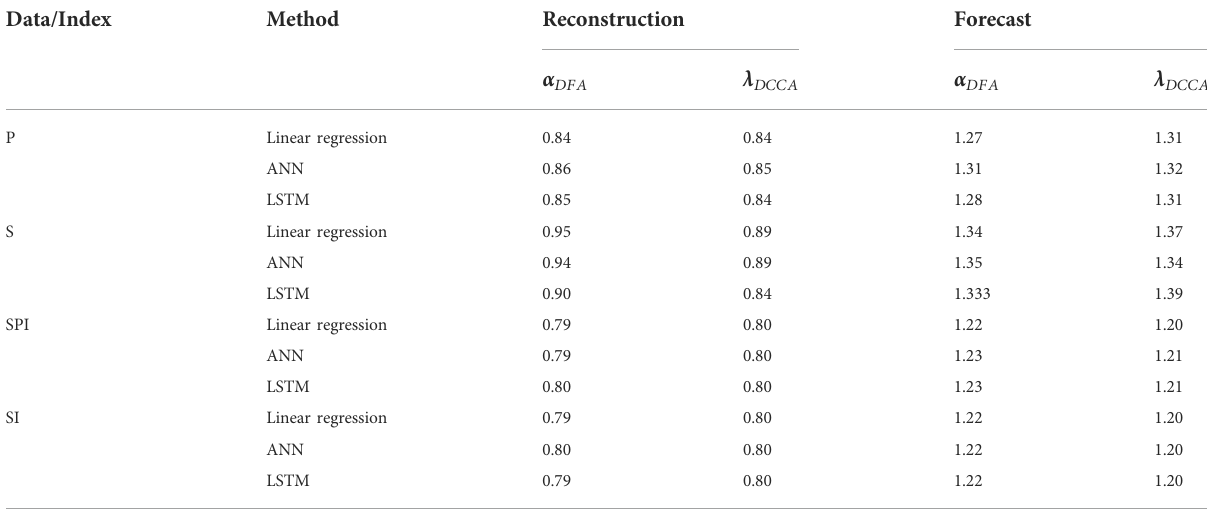
TABLE5 α DFA ofdifferentreconstructedandforecastedrunoffattheKratiestationand λ DCCA ofdifferentreconstructedandforecastedrunoffagainst the Kratie station.